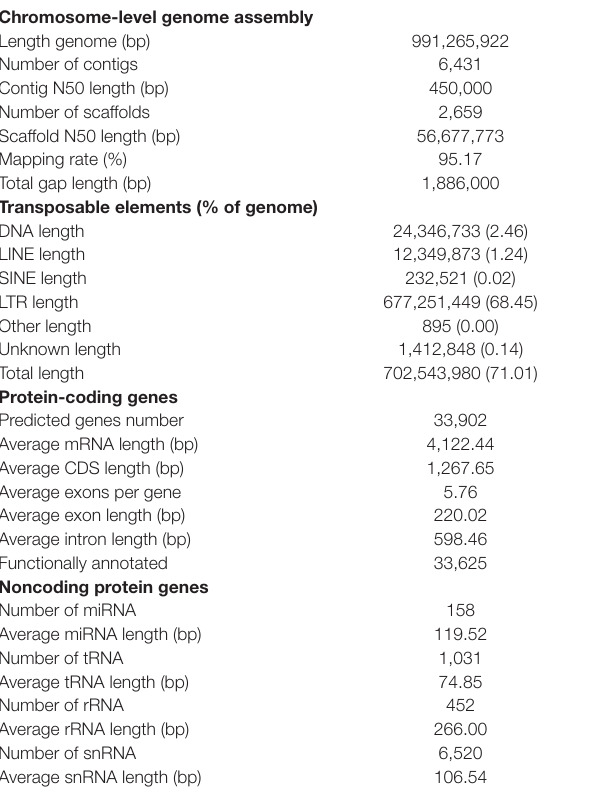
TABLE 1 | Genome assembly and annotation statistics of C. alismatifolia . Chromosome-level genome assembly Length genome